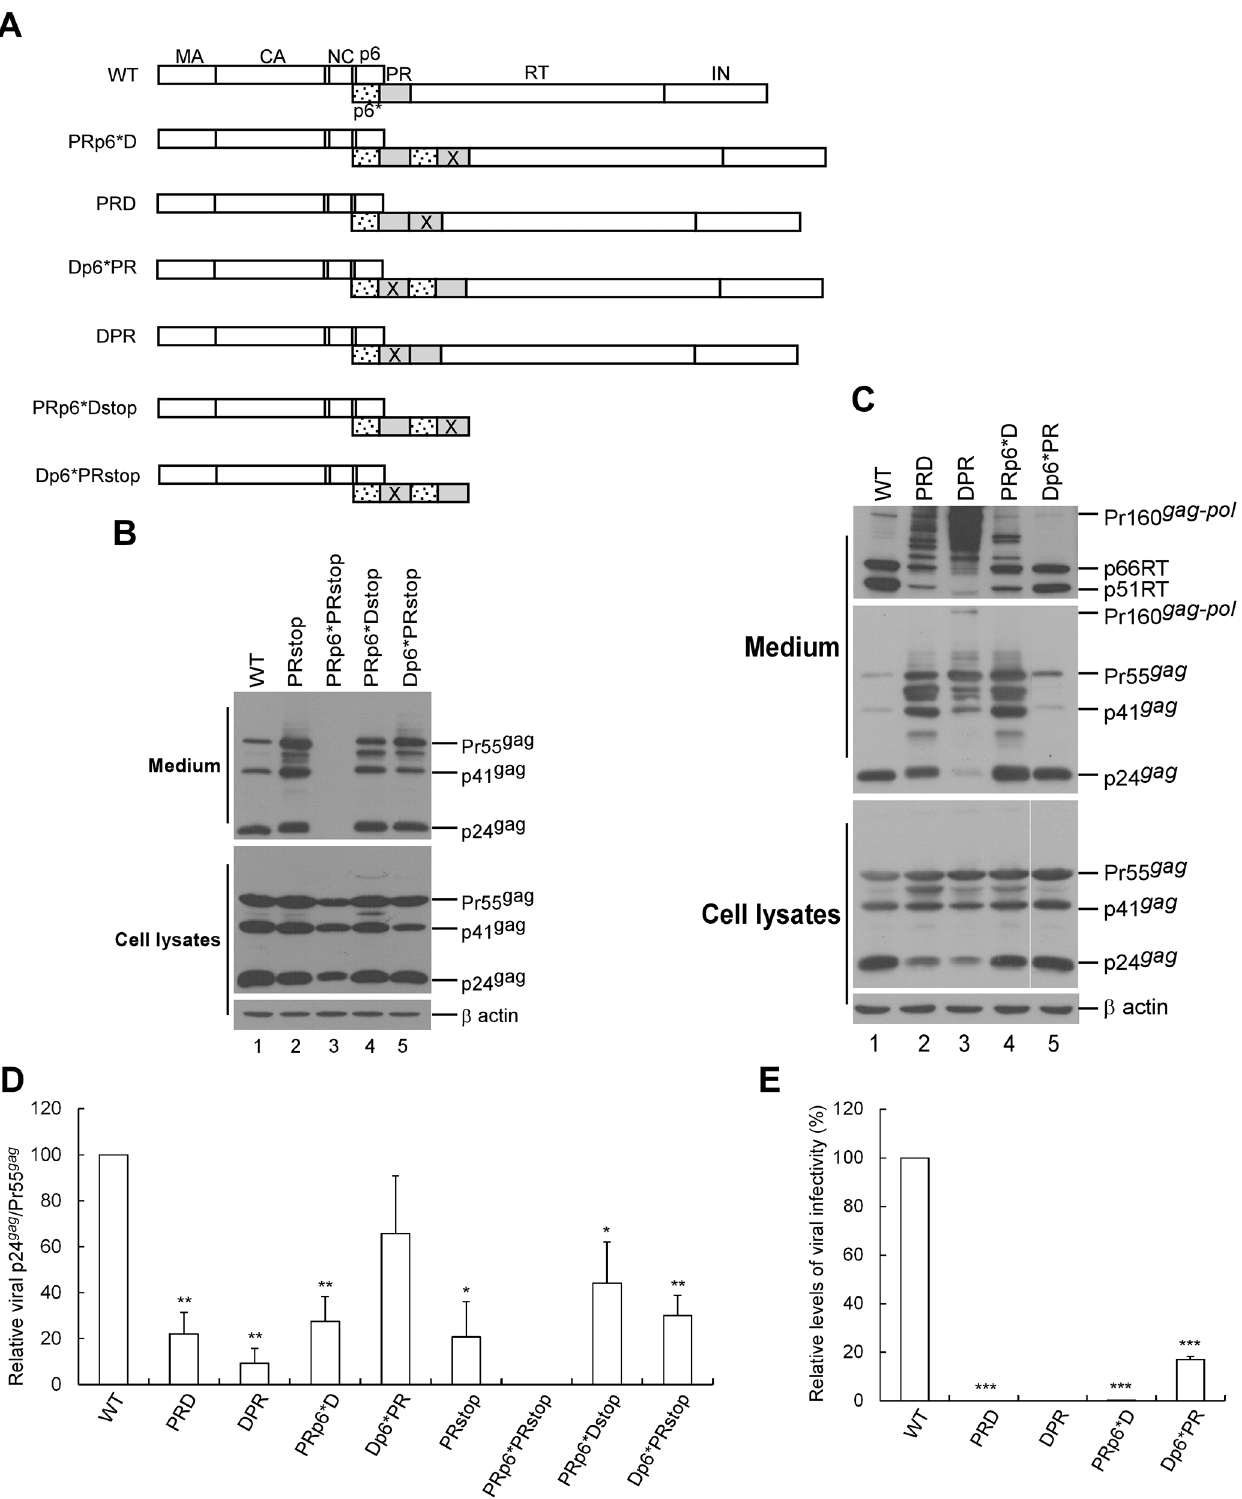
Fig 5. Inactivation of either one of the two PR domains markedly affected virus maturation. (A) Schematic representations of HIV-1 Gag and Gag-Pol expression constructs. X denotes a PR-inactivated mutation. Constructs were derived from PR-inactivated Gag-Pol expression vectors (Fig 4) lacking the gag/pol frameshift mutation. PRp6 * Dstop and Dp6 * PRstop were derived from recombining the PRstop (Fig 3) with PRp6 * D and Dp6 * PR,